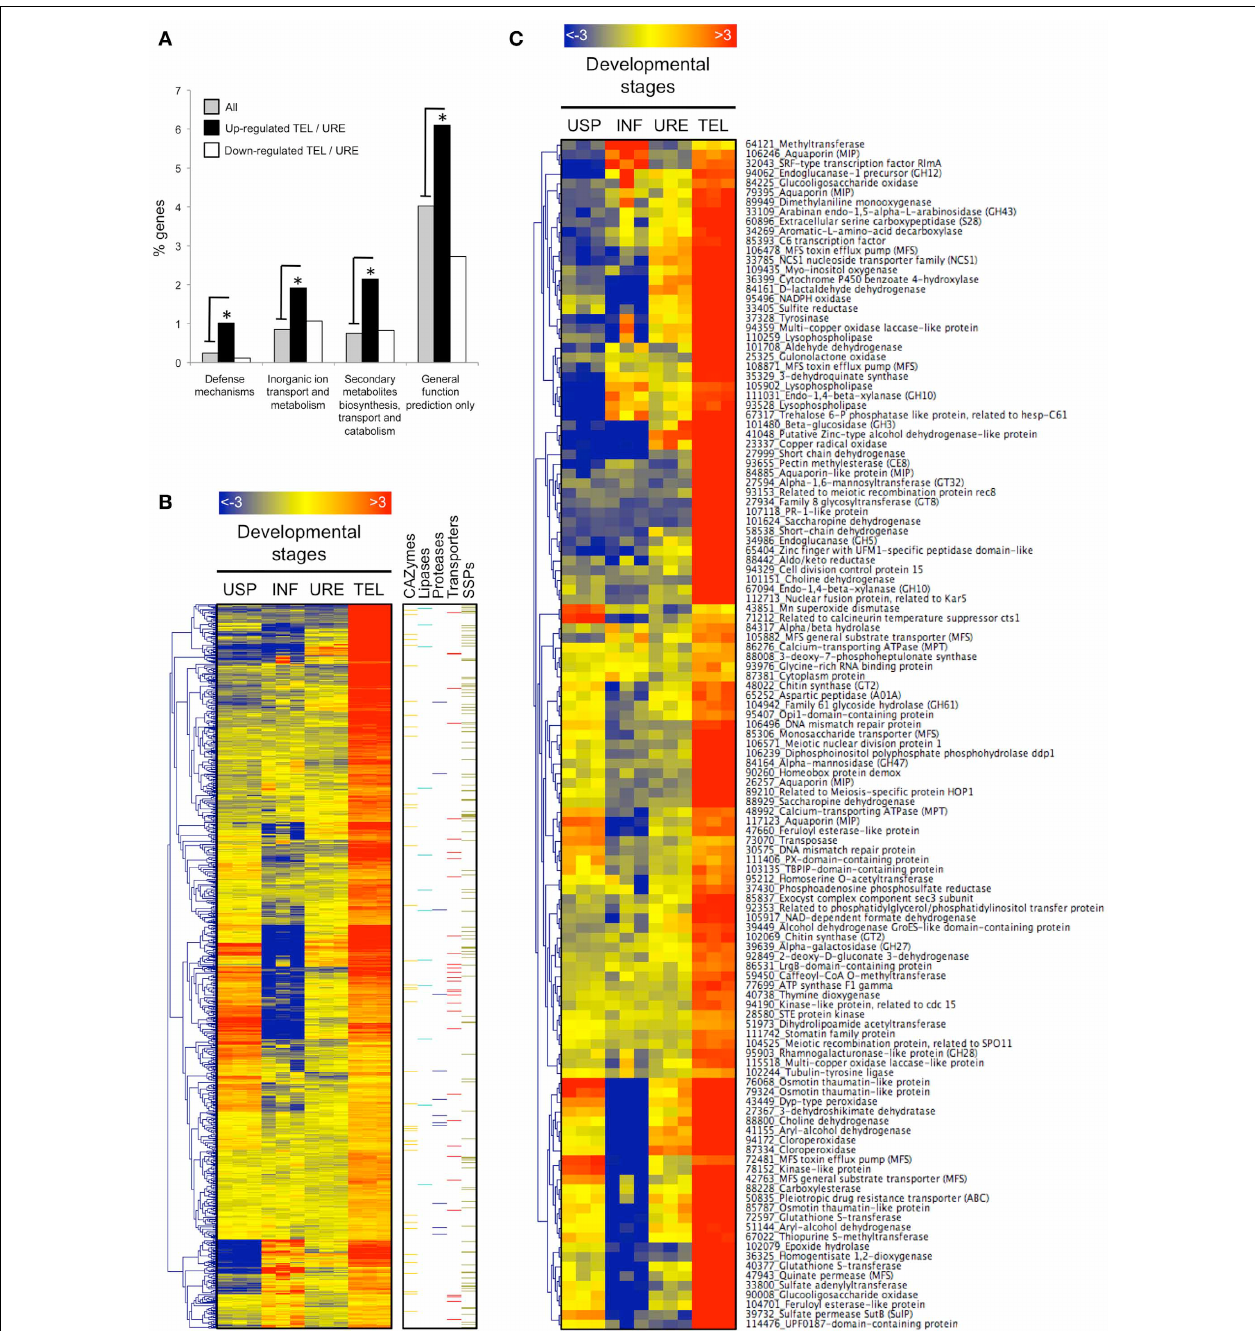
Over-represented (red) or under-represented (blue) transcripts are depicted as log 2 fold-changes relative to the mean expression level measured across all four stages. USP, urediniospores; INF, poplar infected leaves; URE, uredinia; TEL, telia. On the right side, genes belonging to five pathogenicity-related categories (carbohydrate active-enzymes, lipases, proteases, transporters, and small secreted proteins) are highlighted with color bars. (C) Among the genes presented in the panel (B) , only those showing a higher transcript induction in TEL compared with URE (log 2 FC > 2, p < 0 . 05) and having a functional annotation (based on the swissprot database) are highlighted. JGI protein identification number and the associated function are